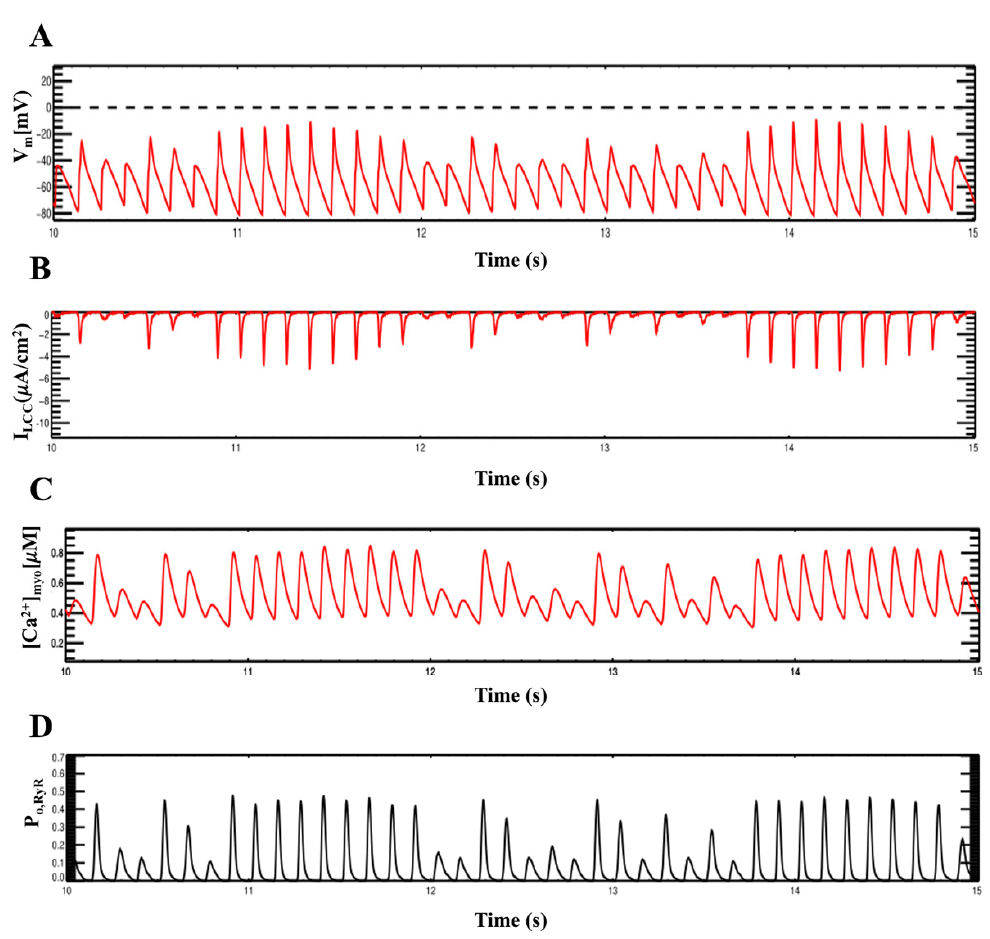
Figure 12. Alternans at high pacing rate (8Hz) using a stochastic Na + current model at 23 ◦ C, ( A ) action potential. ( B ) I CaL current. ( C ) cytosolic calcium. ( D ) opening probability of whole-cell ryanodine